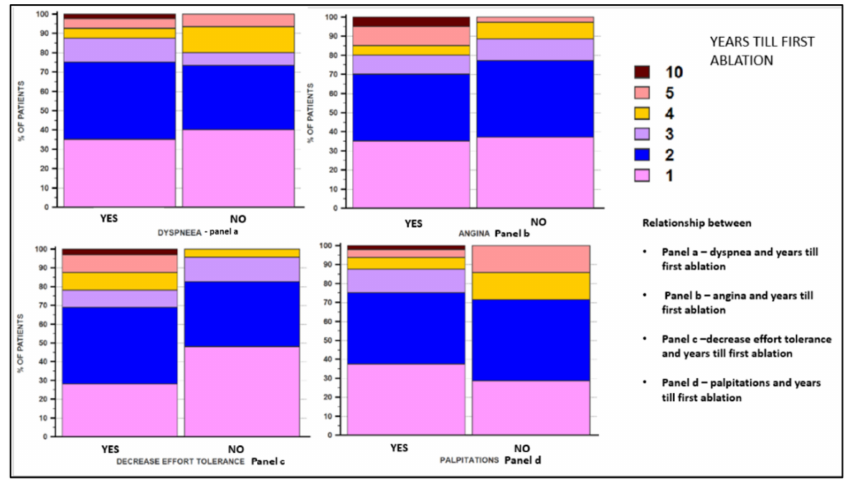
Figure 3. Correlation between patients’ symptoms and the number of years that passed until the ablation was performed, in the general population.